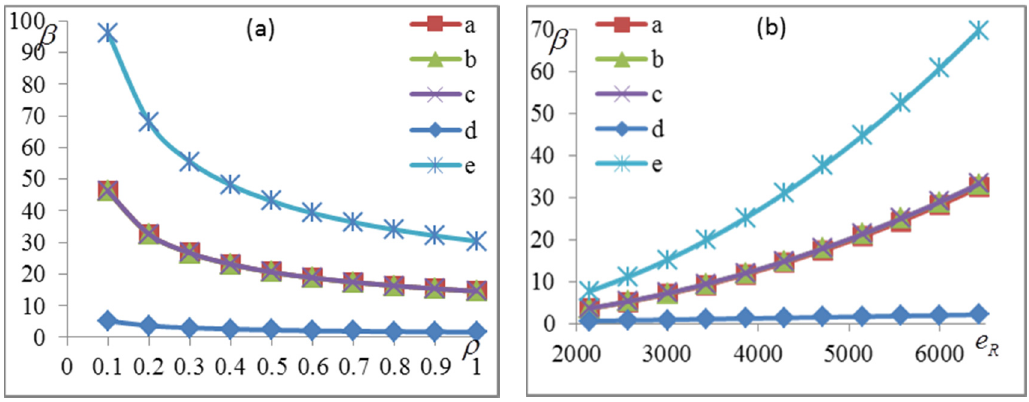
Figure 6. Relationship between system reliability indexes and ( a ) different correlation coefficients and ( b ) different system resistances of two errors of DHF